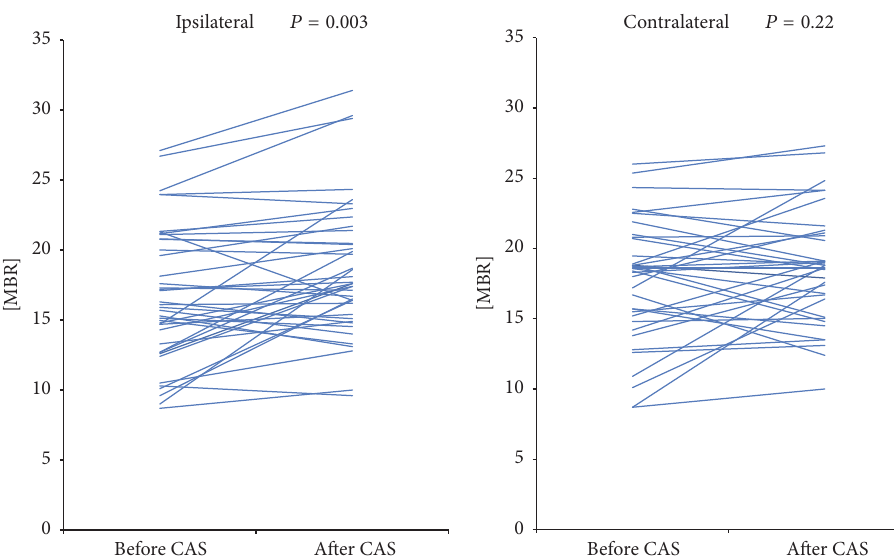
Figure 4: Change in the mean blur rate (MBR) before and after carotid artery stenting (CAS). The MBR on the operated side showed a statistically significant increase following CAS ( 𝑃 = 0.003 ).